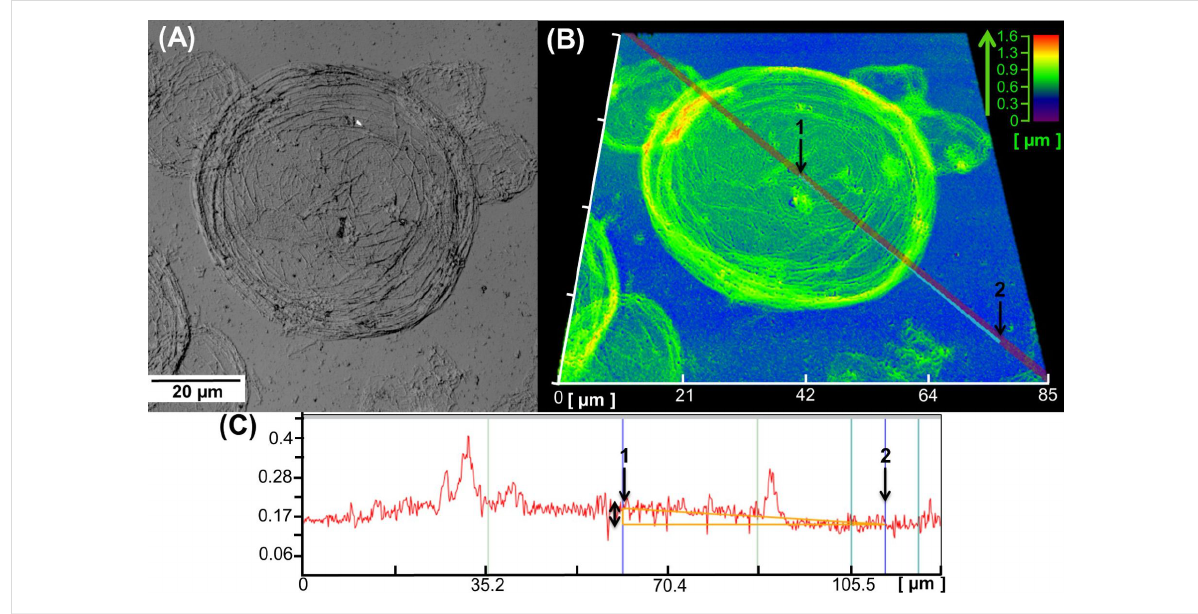
Figure 7: Laser microscope images of the toluene-in-water droplets stabilized by the DM- β -CD/PDI nanogel after evaporation of the toluene cores. (A) Optical image, (B) profile image, and (C) the cross-sectional histogram. Inset arrows and numbers correspond to the orientation for both images (B and